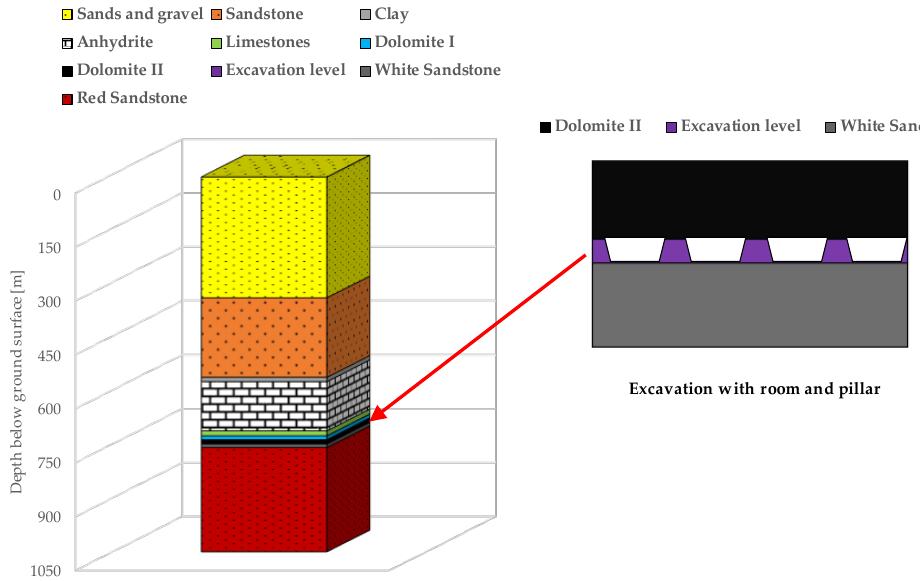
Figure 10. Geologic cross-section of the copper orebody.